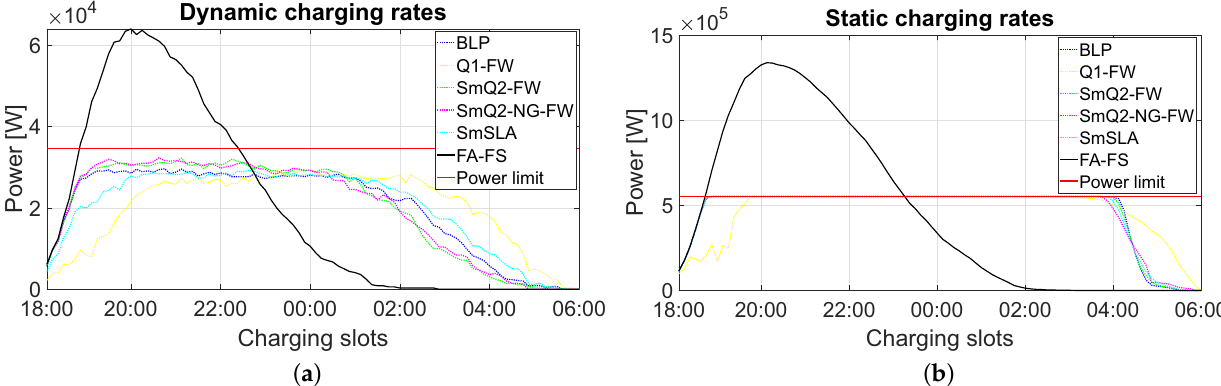
Figure 5. Averaged total power consumed by the whole farm versus the time slots: ( a ) small farm with N = 16 and random charging rates; ( b ) large farm with N = 256 and a constant charging rate.